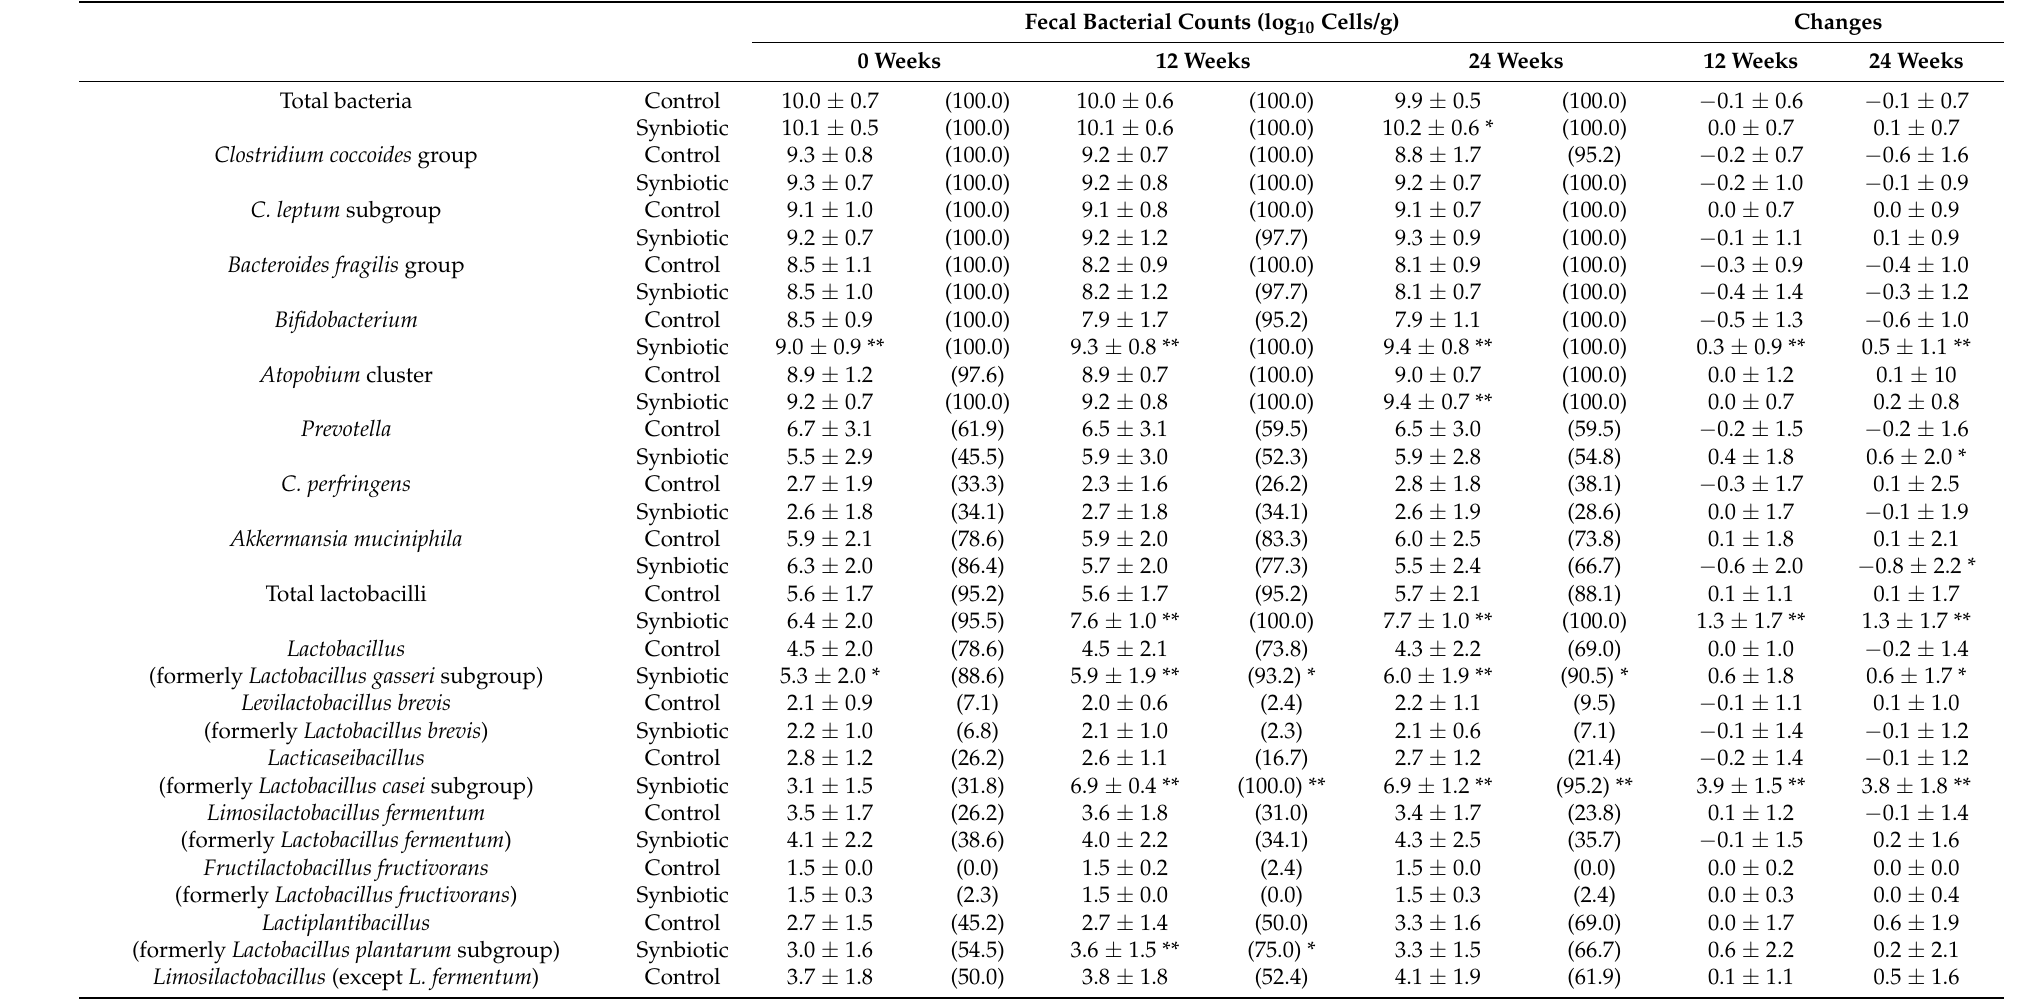
Table 3. Fecal counts of gut microbiota and their changes as determined by